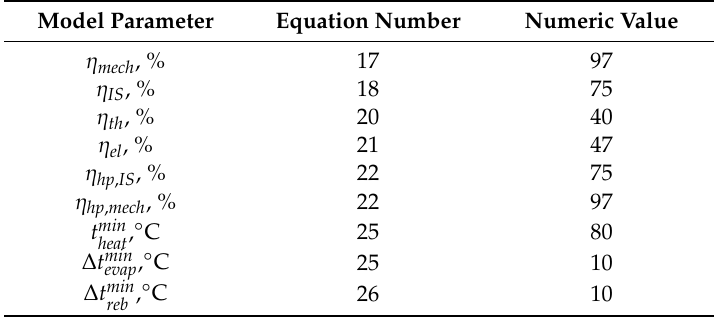
Table 5. Model inputs for heat pump working cycle and combustion engine. Model Parameter Equation Number